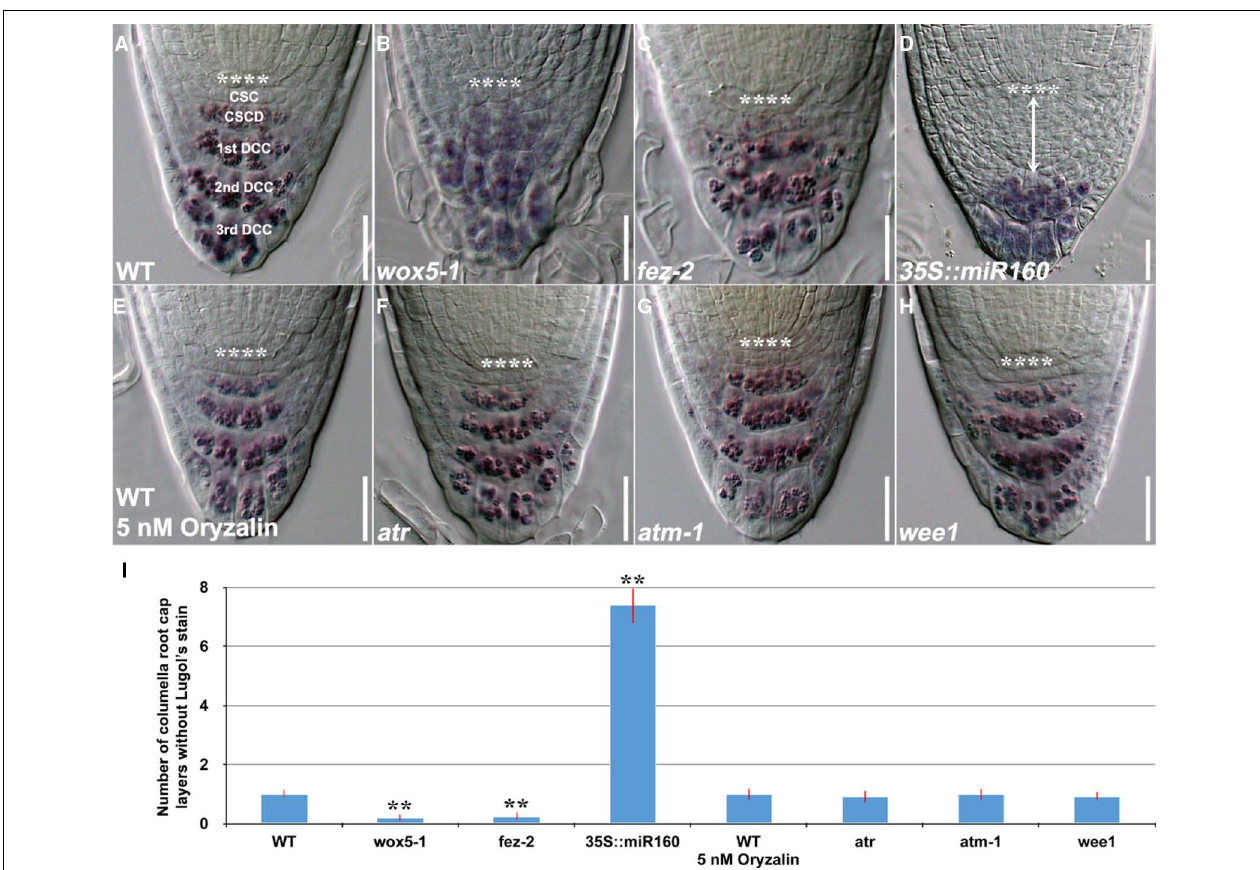
FIGURE 1 | Lugol’s staining showing accumulation patterns of starch granules in the columella root cap of 4-day-old WT and mutant genotypes. (A) WT ( n = 14). (B) wox5-1 ( n = 15). (C) fez-2 ( n = 11). (D) 35S::miR160 ( n = 15). (E) WT treated with 5 nM oryzalin for 24 h ( n = 11). (F) atr ( n = 12). (G) atm-1 ( n = 12) and (H) wee1 ( n = 12). (I) Quantification of the number of layers of unstained columella root cap cells. Error bars represent